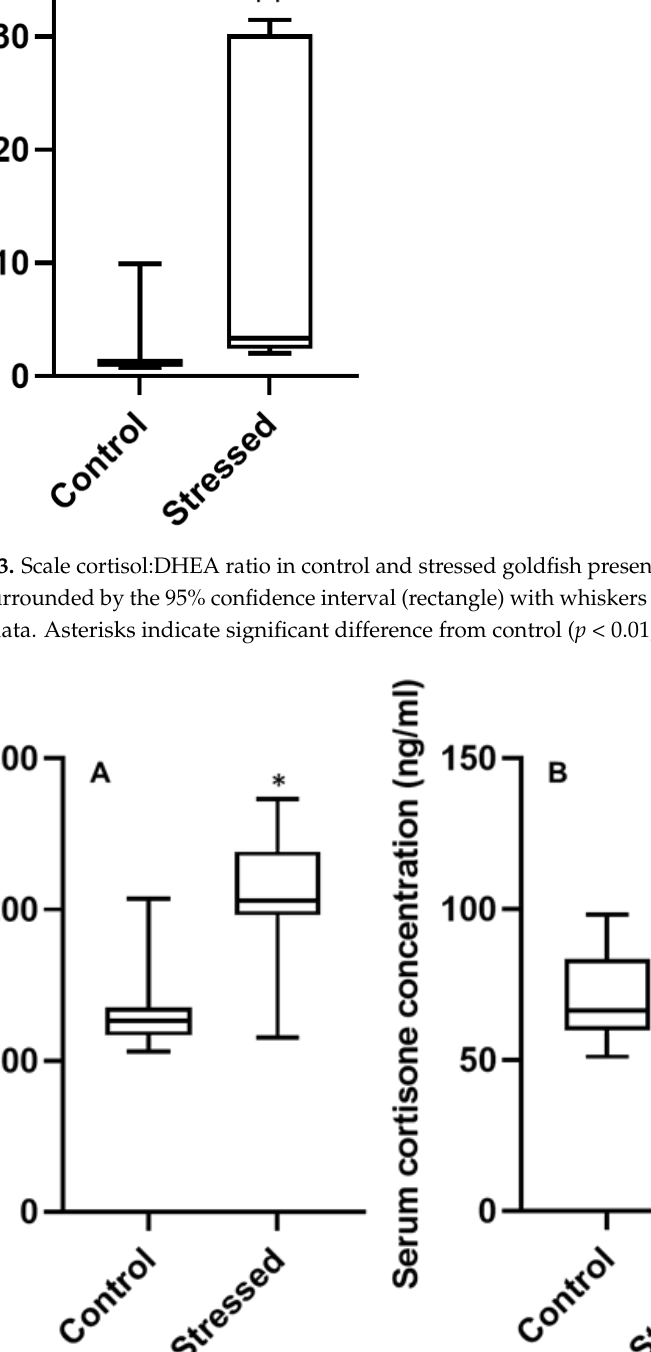
Figure 4. Serum hormone concentrations in control and stressed goldfish: ( A ) cortisol and